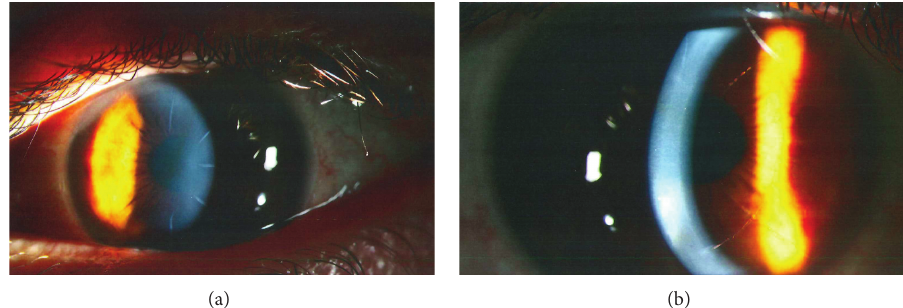
Figure 2: Slit Lamp Photography. Patient’s right eye detailing: (a) radial keratotomy incisions and (b) astigmatic keratotomy incision. Even though the patient had LASIK, it is difficult to appreciate the LASIK flap in these